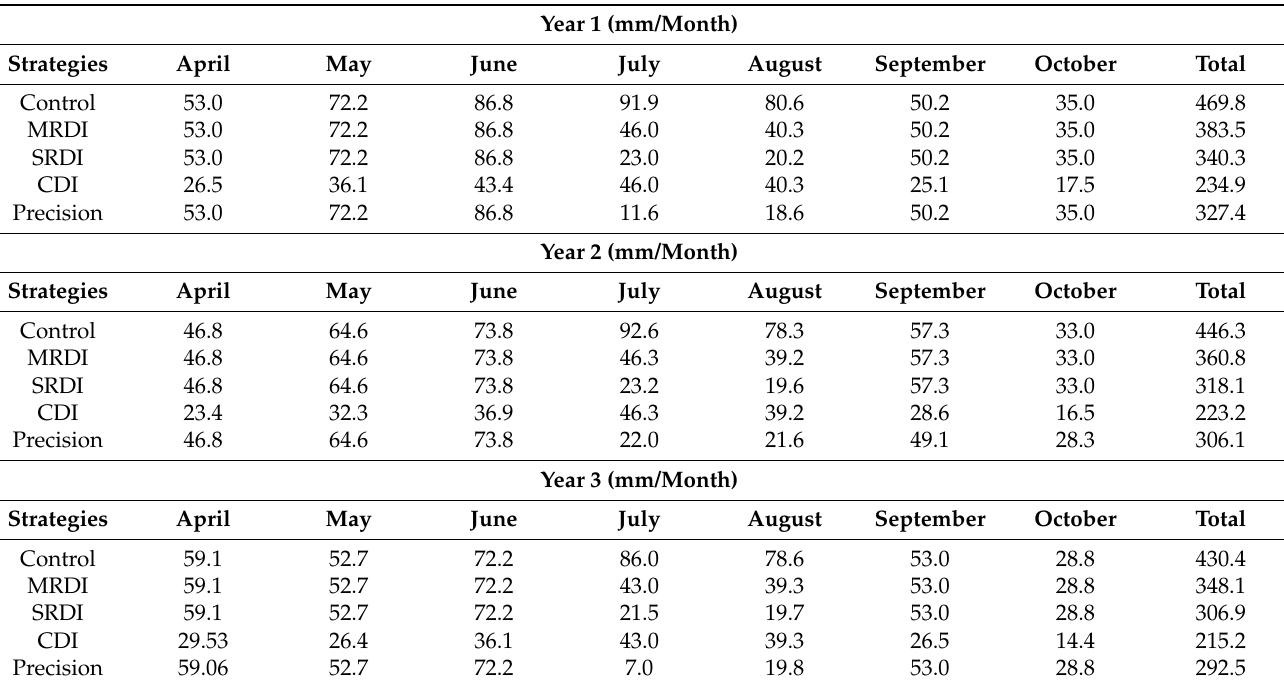
During summer (July and August), daily trunk growth data was used to support irri- gation decisions reducing water consumption in comparison with the rest of the irrigation strategies, except for CDI, for which the total amount of water was lower (Table 5). Table 5. Monthly irrigation volume (mm) for each irrigation strategy during three tested years. (MRDI: moderate regulated deficit irrigation; SRDI: severe regulated deficit irrigation; CDI: continu- ous deficit